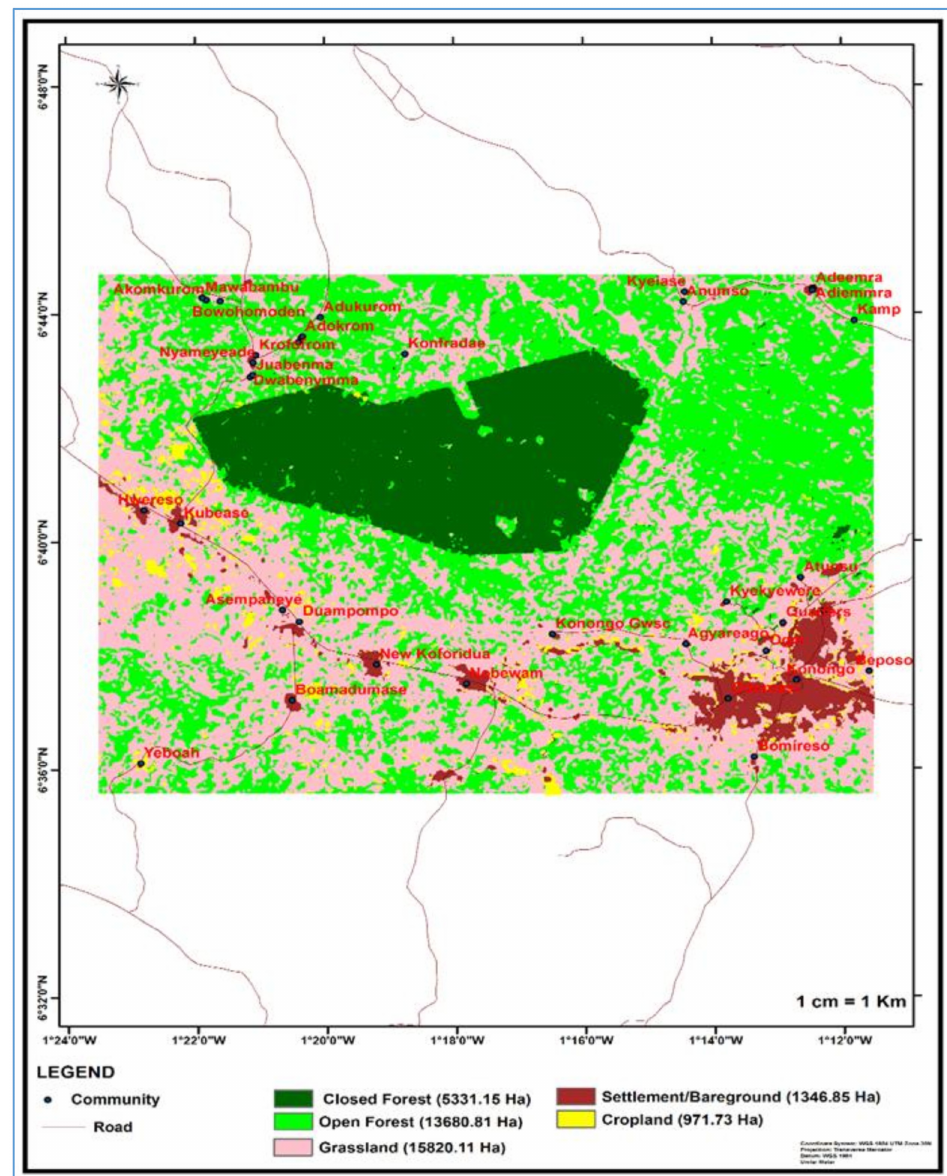
Figure 7. Landsat image of Bobiri forest reserve in